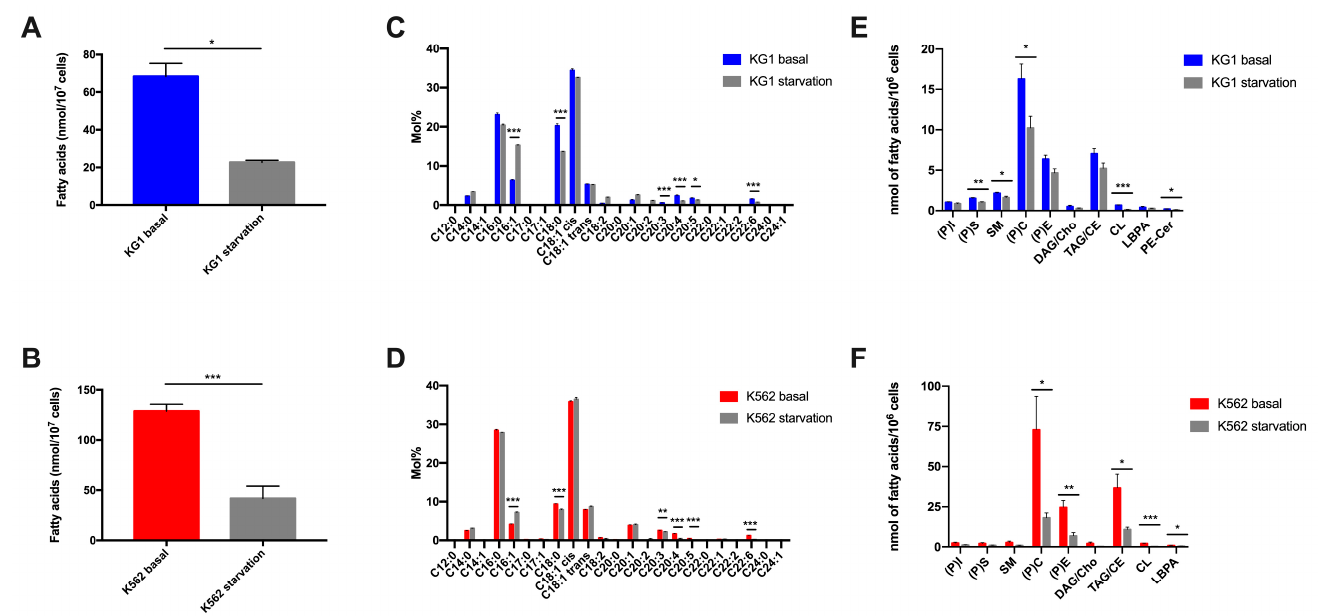
Figure 2. Impact of the nutrient depletion on the two cell lines KG1 and K562. ( A , B ) Total fatty acid amount in KG1 and K562, respectively, at basal state versus in starvation. ( C , D ) Composition of total fatty acids in KG1 and K562, respectively, at basal state versus in starvation. ( E , F ) Lipid species quantification in KG1 and K562, respectively, at basal state versus in starvation. * p < 0.05, ** p < 0.01, *** p < 0.001.